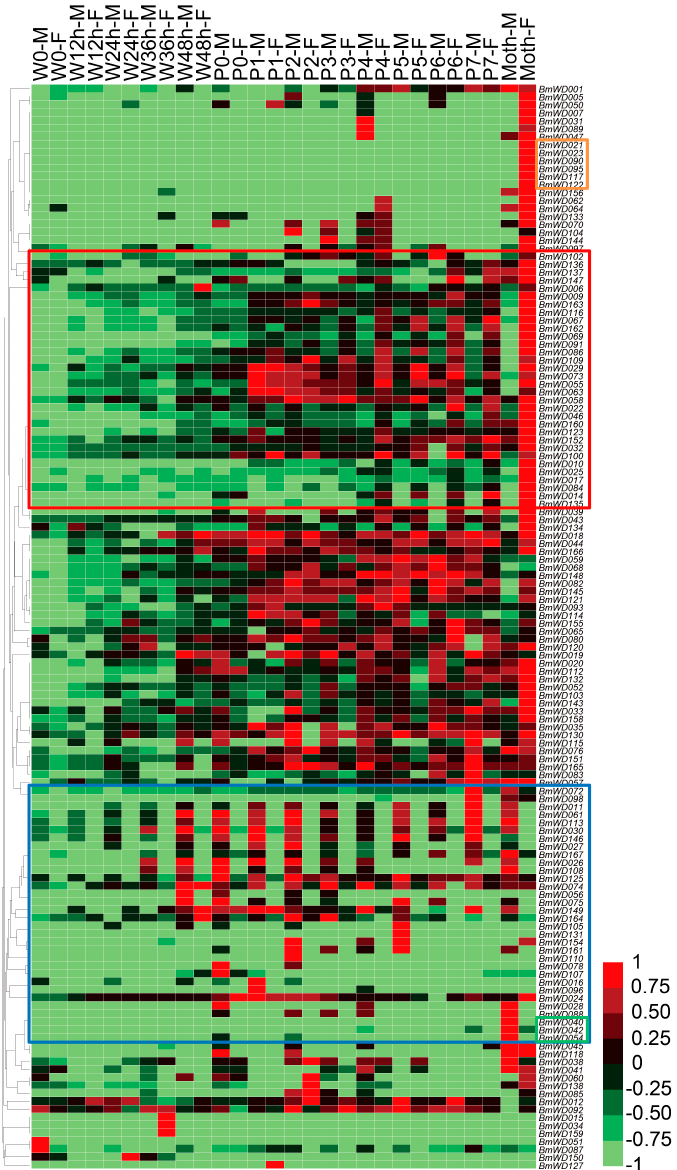
Figure 9. Microarray-based gene expression profiling of BmWD40 genes during silkworm metamorphosis. One hundred thirty six BmWD40 genes were detected to be expressed during silkworm metamorphosis. M: Male, F: Female, W: Wandering (W0: beginning of Wandering for spinning, W12 h: 12 h after Wandering), P: Pupation (P0: beginning of Pupation, P1: one day after Pupation), h: hour. Most genes in the red box were specifically highly expressed in female, whereas most genes in the blue box were male-specific. Genes in the green box exhibited male-moth-specific high expression. Genes in the orange box showed female-moth-specific